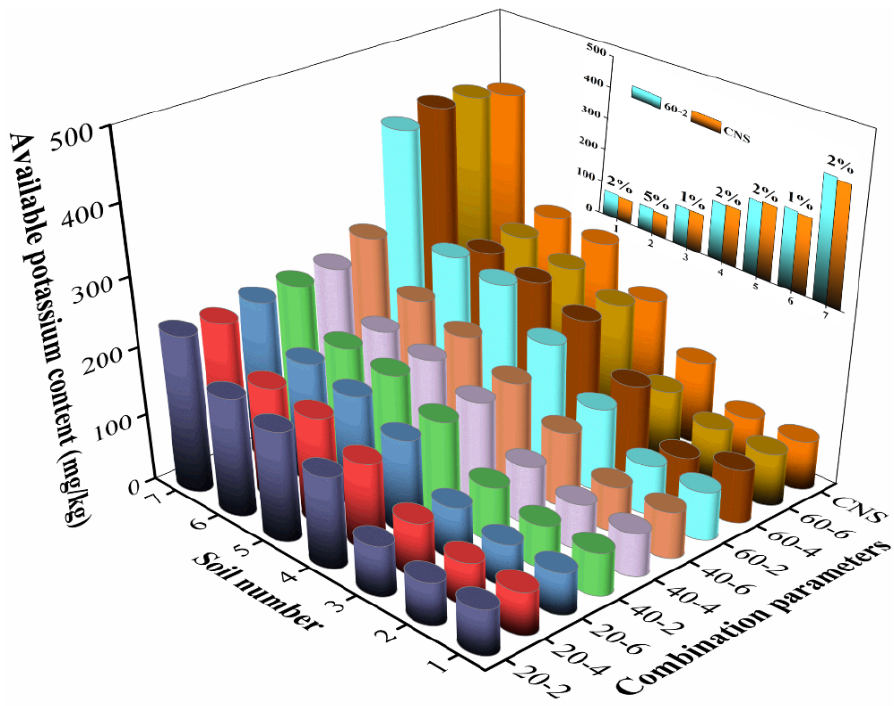
Figure 4. Available K content of seven soil samples based on different combination parameters and Chinese national standard (CNS) method, including a detail image showing the relative deviation between 60–2 and the CNS method.